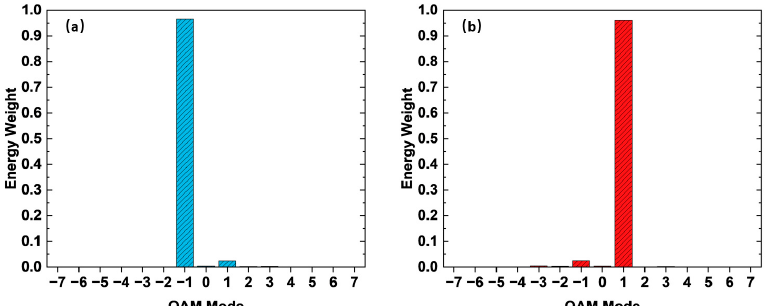
Figure 9. OAM spectrum. ( a ) Topological charge distribution of the left-handed component under the incidence of left-handed polarized light. ( b ) Topological charge distribution of the right-handed component under the incidence of right-handed polarized light.